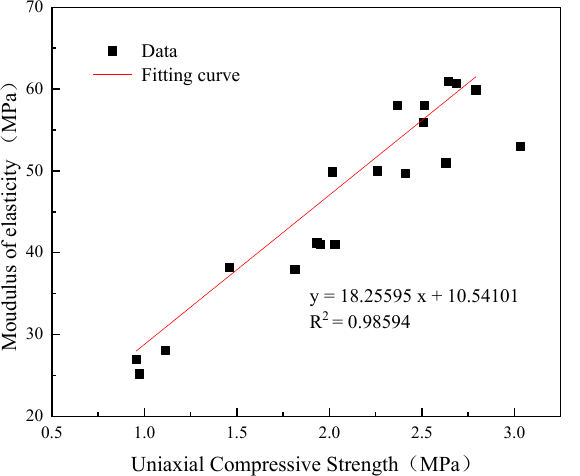
Figure 19. Regression analysis between elastic modulus and uniaxial compressive strength.